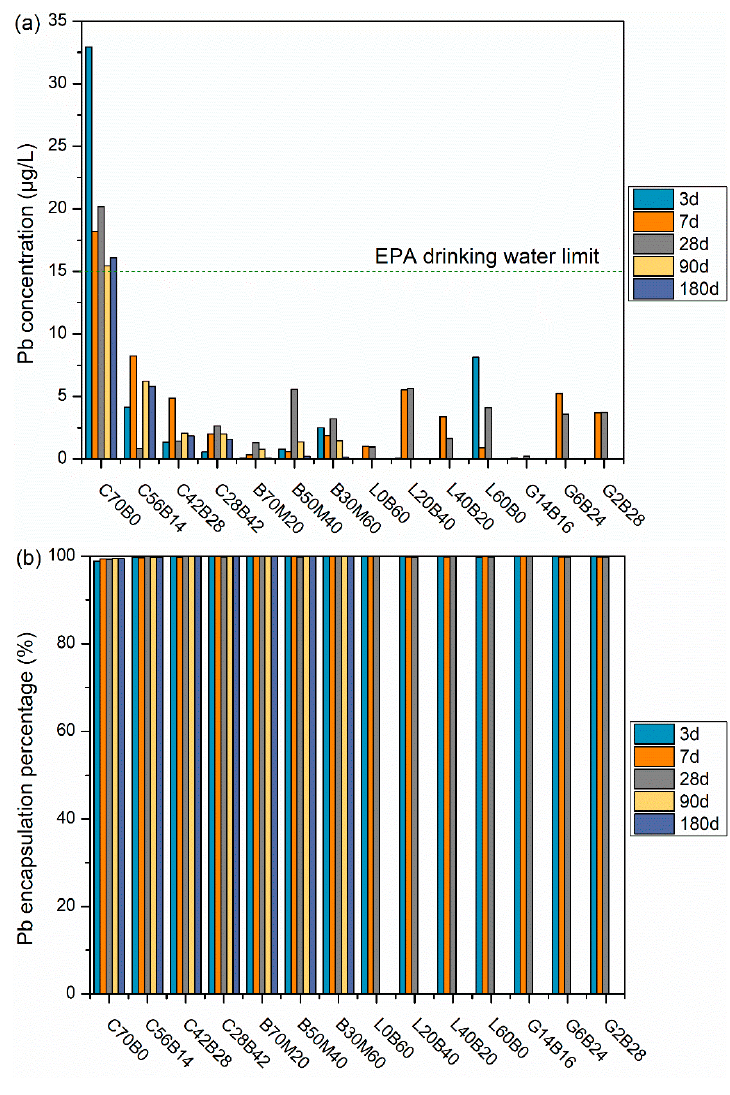
Figure 8. The ( a ) Pb concentration and ( b ) encapsulation percentage for the leachate in all groups